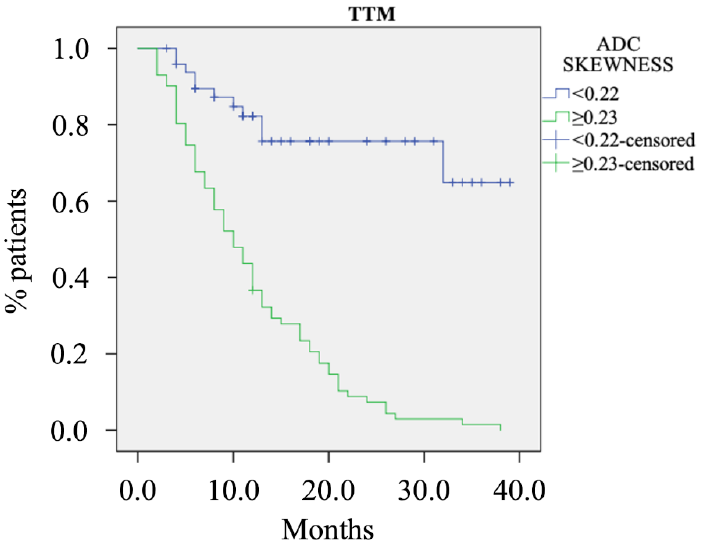
Figure 4. Kaplan–Meier curve for ADC skewness. Legend: TTM, time to Figure 4. Kaplan – Meier curve for ADC skewness. Legend: TTM, time to metastases.